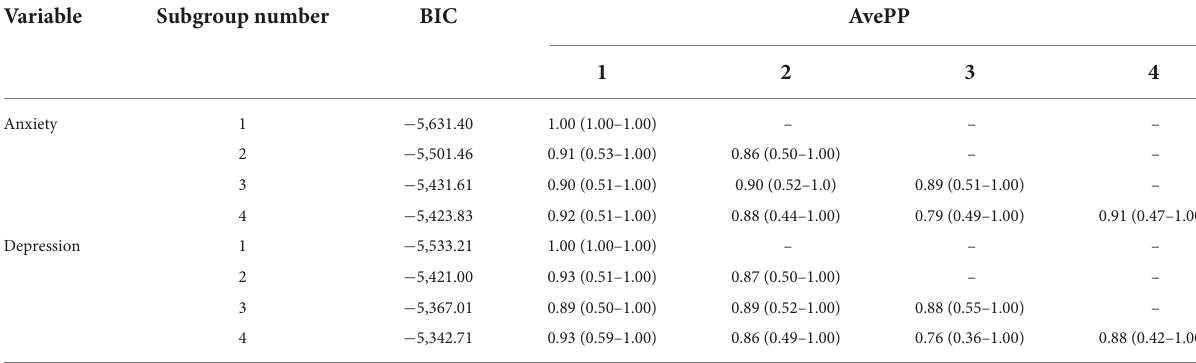
TABLE 2 Comparison of the model fit index between different subgroup number in anxiety and depression among men who have sex with men (MSM). Variable